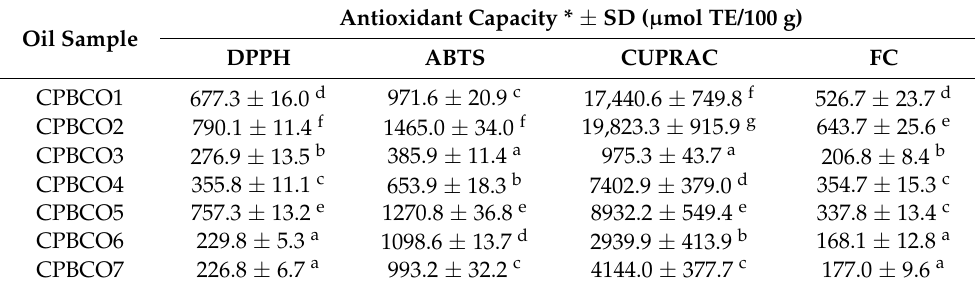
Table 4. Antioxidant capacity levels of cold-pressed black cumin